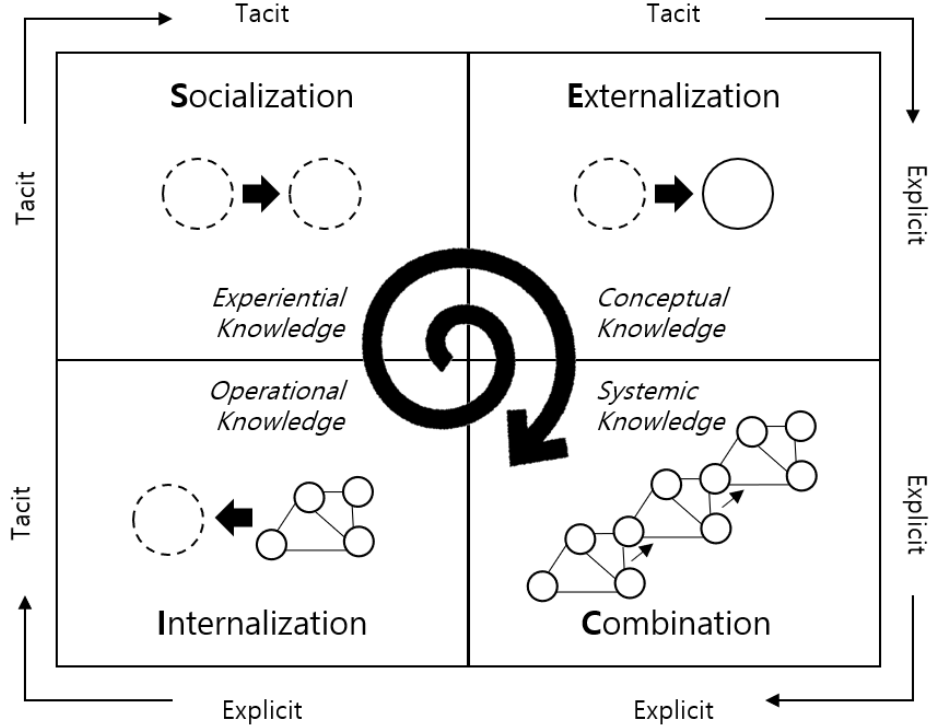
Figure 3. Knowledge-creating process (SECI) model. Through the SECI model, we examined the characteristics of the moments where knowledge conversion could occur due to the interactions of knowledge. Nonaka uses a “knowledge spiral” graph to explain the impact of the knowledge conversion process on society [16]. In the knowledge spiral graph, the epistemological level represented by tacit and explicit knowledge is on the vertical axis, and the ontological level of the entities that create it is on the horizontal axis. In the graph, the knowledge spiral appears when tacit knowledge springing from an individual is dynamically boosted while circulating the processes of S (socialization), E (externalization), C (combination), and I (internalization); through these interactions, it is gradually amplified and finally exceeds the ontological dimension, thereby forming a societal knowledge paradigm [10] (Figure 4).